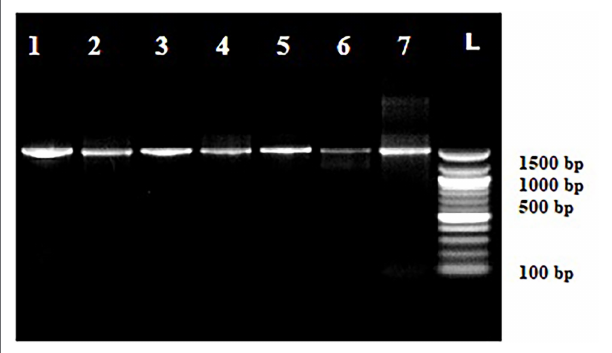
FIGURE 2 | Amplification of 16S-rRNA in cadmium tolerant species. Lanes, 1 Pseudomonas putida , Lanes, 2 Bacillus pumilus , Lanes, 3 Klebsiella pneumoniae , Lanes, 4 Pseudomonas mandelii , Lanes, 5 Pseudomonas avellanae , Lanes, 6 Enterobacter kobei , and Lanes, 7 Staphylococcus equorum . Lanes, 8 Ladder (100 bp